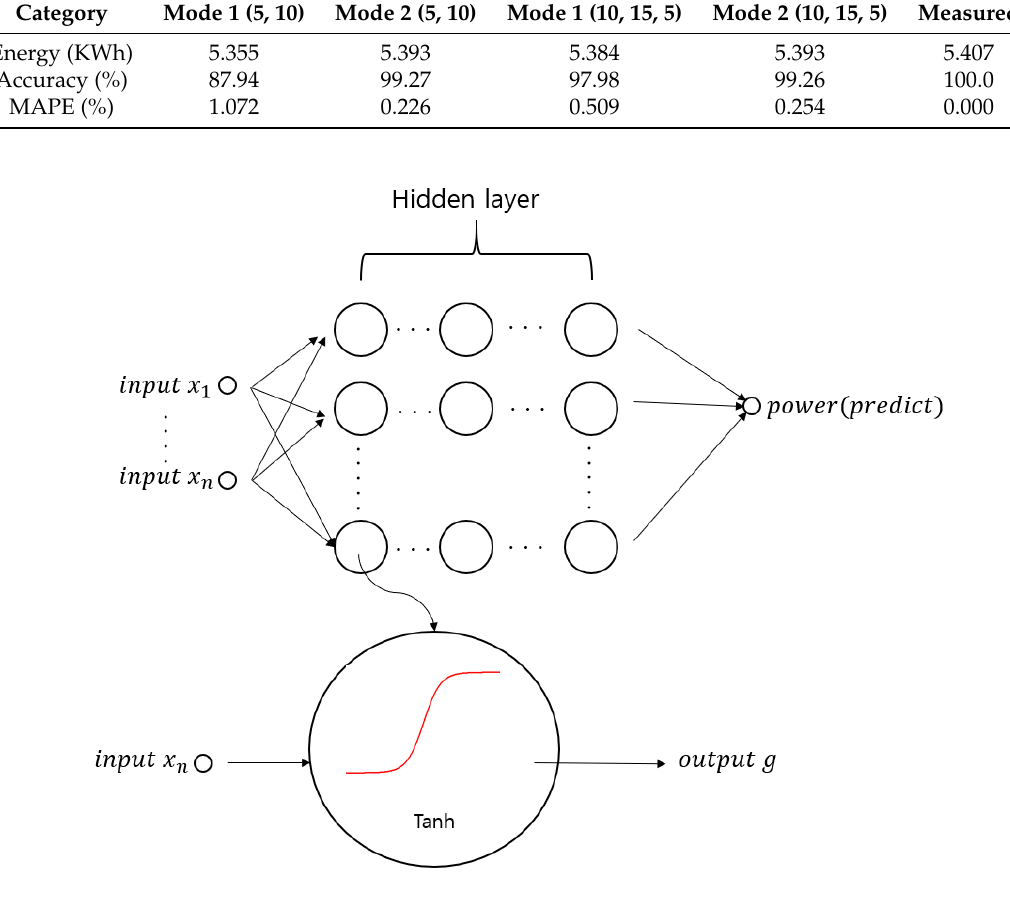
Figure 13. Neural network